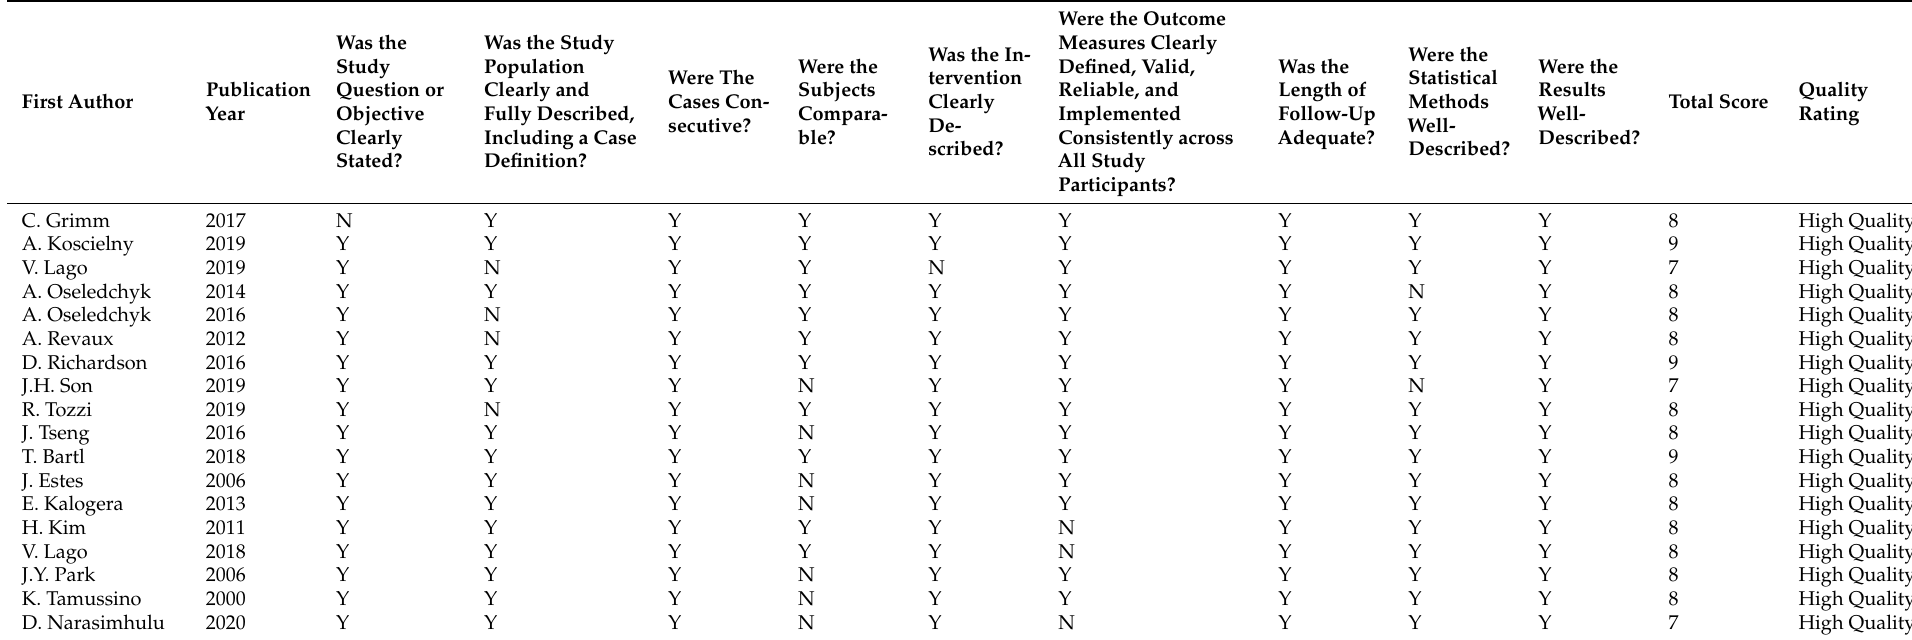
Table 3. The risk of bias assessment using the Risk of Bias tool of the National Heart, Lung and Blood Institute (NHLBI). Y = Yes. N =